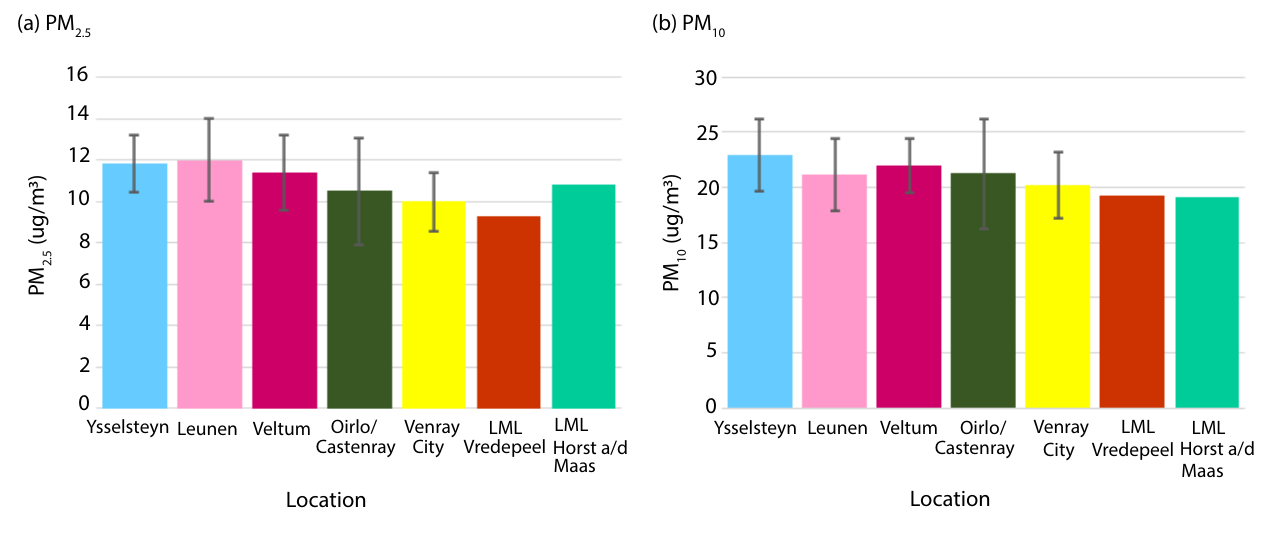
Figure 4. Yearly average concentrations of PM 2.5 and PM 10 . Average concentrations for the five areas and for the two nearby official measurement stations (Vredepeel and Horst aan de Maas). 2 times standard deviation (95% CI; shown by the error bars) is